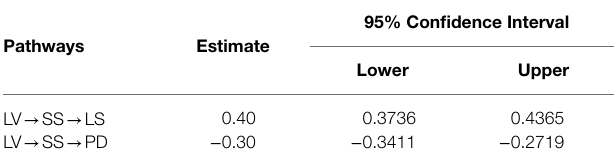
TABLE 2 | Standardized indirect effects and 95% confidence intervals.